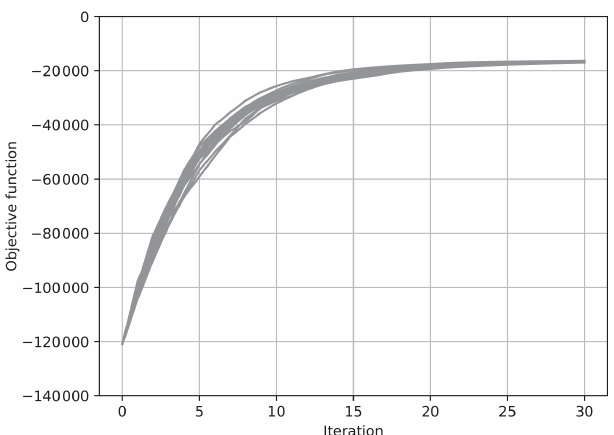
Figure 9. The value of the objective function J for each iteration for 20 trials of the estimation for the 400 dimensional system. The ensemble was updated using Eq. (36) with δ = 1 . 5 × 10 − 3